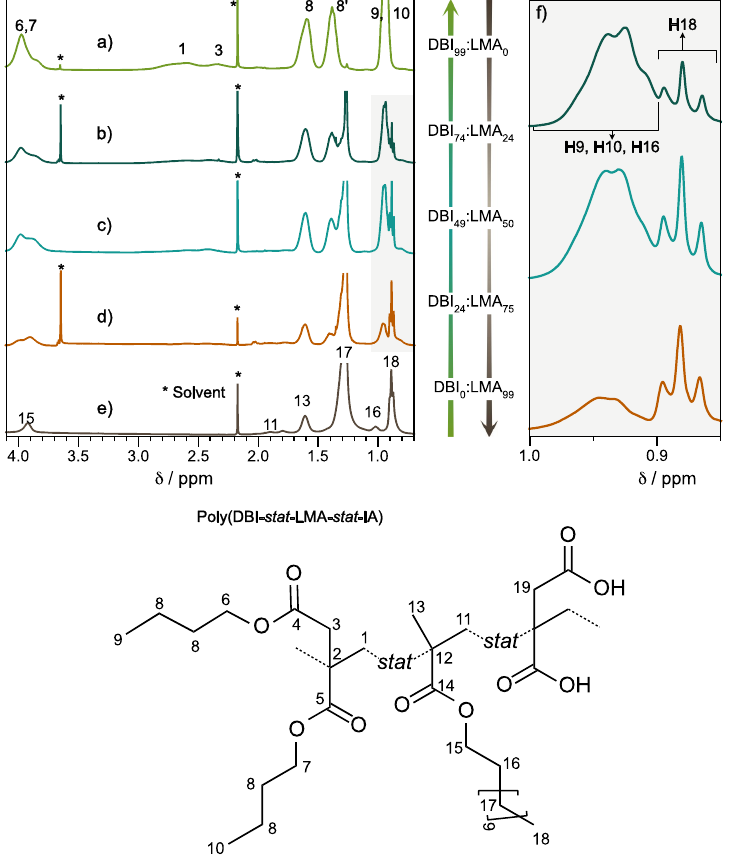
Figure 2. 1 H-NMR spectra of films copolymers in CDCl 3 . ( a ) PSA-1000; ( b ) PSA-2000 (Poly(DBI 74 - stat -LMA 25 - stat -IA 01 )); ( c ) PSA-3000 (Poly(DBI 49 - stat -LMA 50 - stat -IA 01 )); ( d ) PSA-4000 (Poly(DBI 24 - stat -LMA 75 - stat -IA 01 )); ( e ) PSA-5000; ( f ) Expansion of the region δ = 0.8–1.05 ppm of the copolymers PSA-2000, PSA-3000, and PSA-4000.